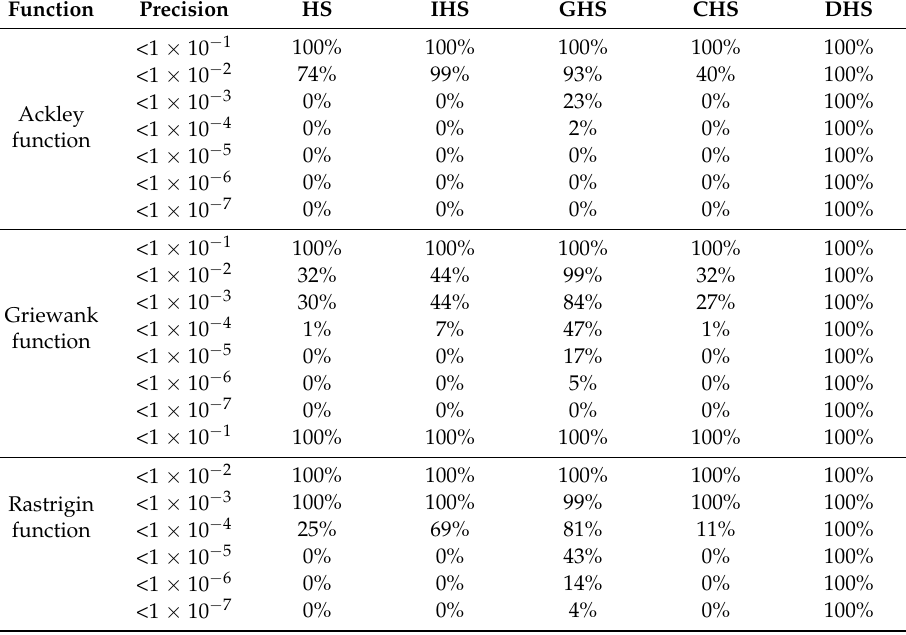
Table 4. Distribution of error of the